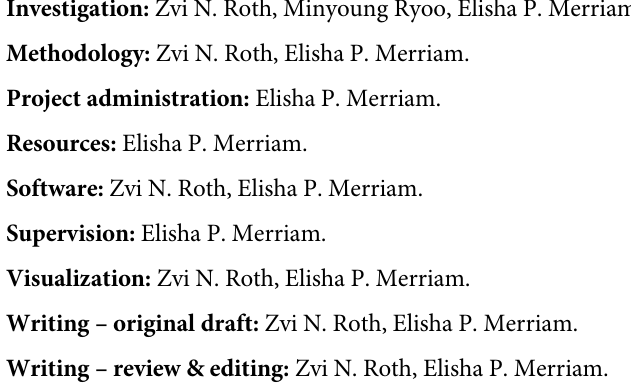
S6 Fig. Simulated response amplitude as function of noise level for first (left panel) and second (right panel) simulations. Amplitude was computed as the standard deviation of the time series presented in Fig 6 and normalized relative to amplitude at noise level 1 (i.e., no noise). Amount of independent noise and amplitude jitter had no systematic impact on response amplitude, whereas amplitude drops monotonically with increasing temporal